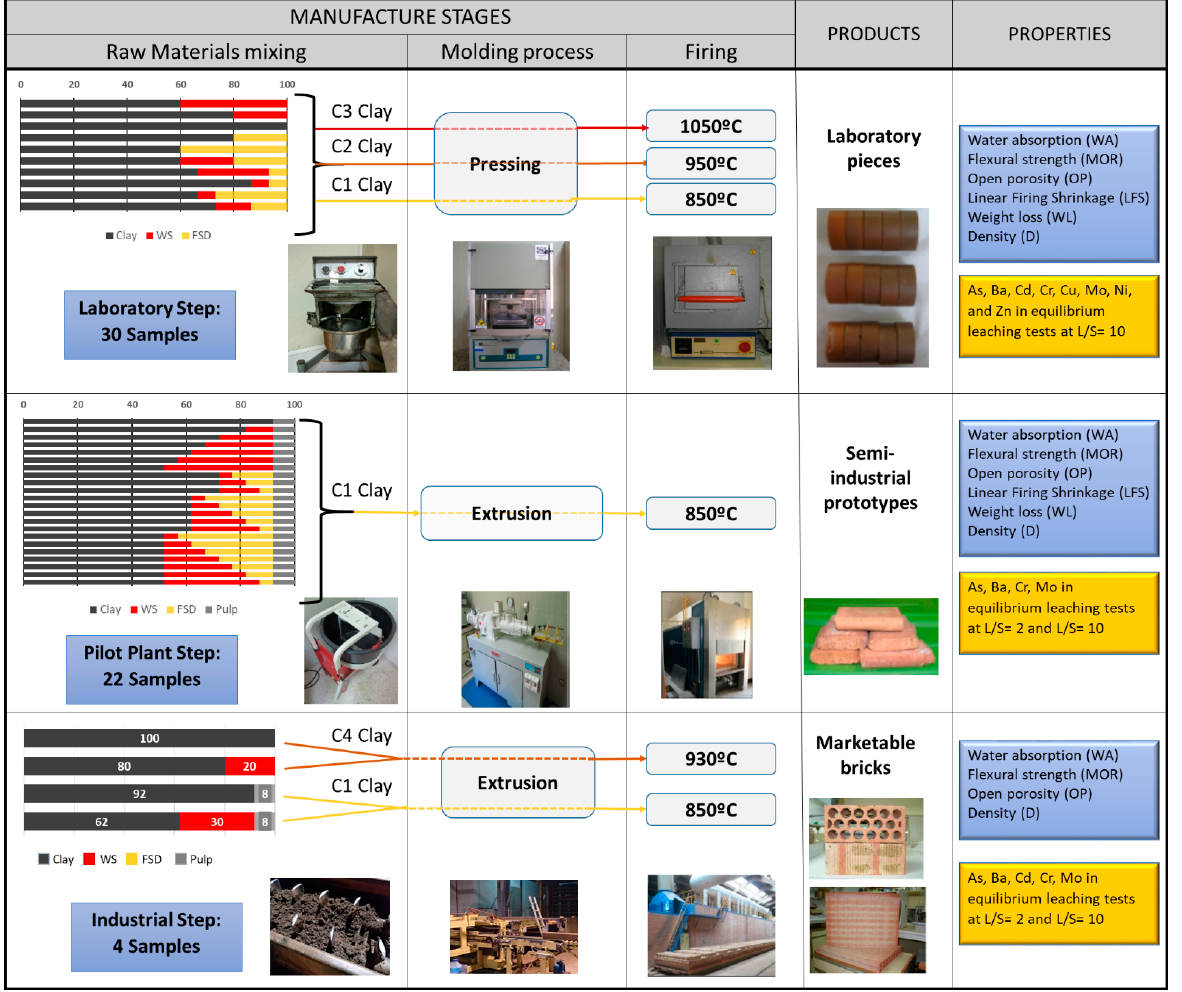
Figure 1. Stages in the manufacture of the studied ceramic products and analysed properties.